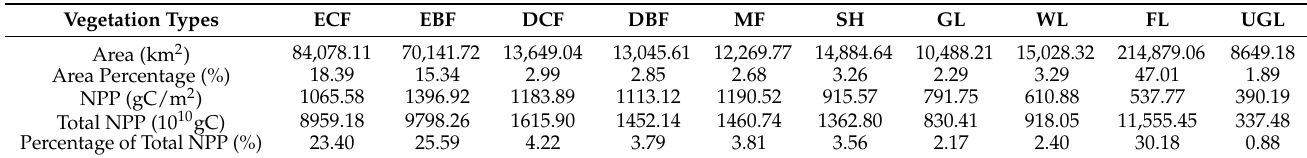
Table 3. Annual mean NPP of the unchanged vegetation types in the six provinces along the southeast coast of China.